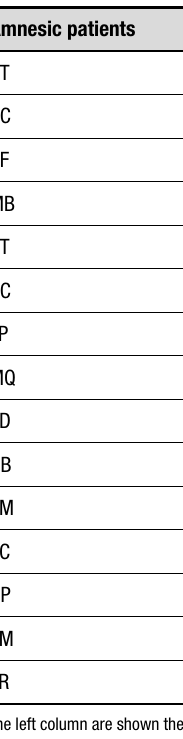
Table 1. Etiology of amnesia, age, and schooling of patients.